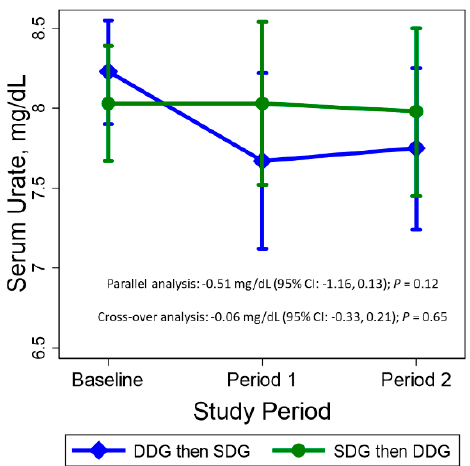
Figure 2. Mean serum urate by sequence assignment at baseline, period 1, and period 2. For the 22 assigned to the Dietitian-Directed DASH groceries (DDG) followed by the self-directed groceries (SDG), the mean serum urate at baseline, period 1, and period 2 was: 8.23 (SD, 0.74), 7.67 (SD, 1.25), and 7.75 (SD, 1.15) mg/dL, respectively. For the 21 assigned the self-directed groceries followed by the DASH groceries, the mean serum urate at baseline, period 1, and period 2 was: 8.03 (SD, 0.79), 8.03 (SD, 1.13), and 7.98 (SD, 1.15) mg/dL. The parallel analysis compared SU measured after period 1 between adults assigned DDG versus SDG. This comparison was adjusted for baseline. The crossover analysis compared DDG to SDG using SU measurements from both period 1 and period 2.